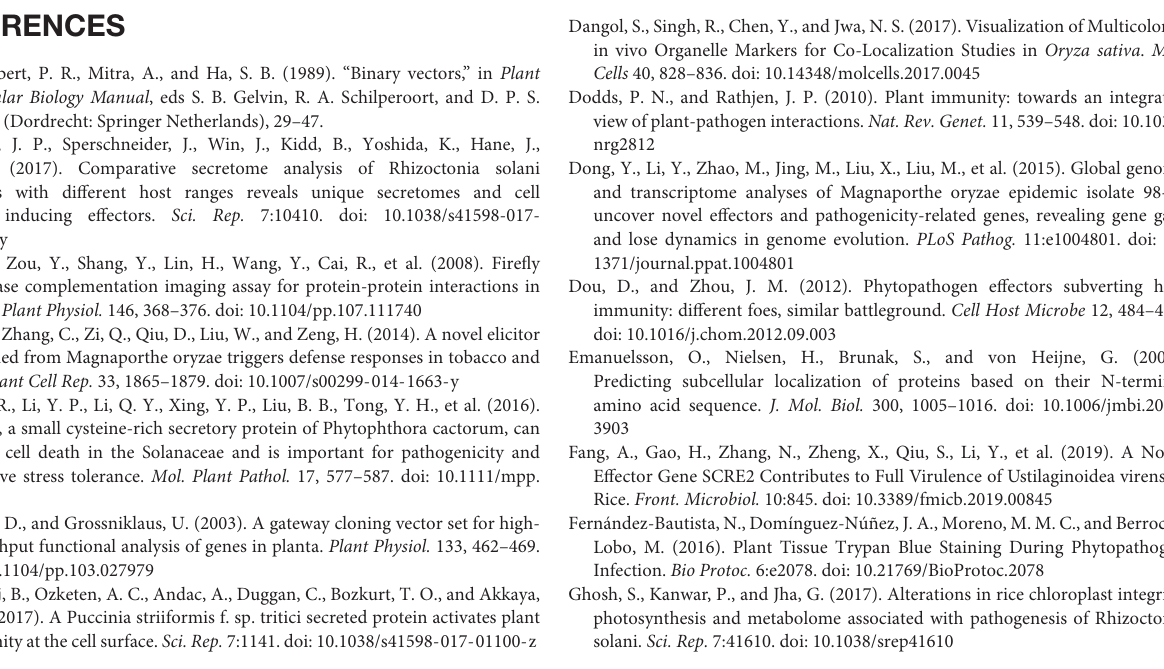
Supplementary Figure 1 | RsSCR10 triggers plant immunity responses in N. benthamiana . (A) Cell death in N. benthamiana leaves indicated by trypan blue staining. GFP and Bax were used as negative and positive controls, respectively. Typical symptoms were photographed at 4 days postinfiltration. (B) Accumulation of ROS and deposition of callose in N. benthamiana . For observation of callose, bars = 100 µ m. Experiments were replicated at least three times. Supplementary Figure 2 | RsSCR10 induced upregulated expression of genes related to H 2 O 2 synthesis in N. benthamiana . Asterisks indicate statistical significance (Student’s t -test) at *5% level and **1% level. Error bars represent standard errors from three biological replicates. Supplementary Figure 3 | Sequence alignment of RsSCR10 in 25 strains of R. solani AG1 IA. Supplementary Figure 4 | RsSCR10 localization analysis in rice protoplasts. (A–D) The fusion protein (RsSCR10-YFP) was coexpressed with the plasma membrane marker (OsPIP2.1-mCherry) (Dangol et al., 2017). (G–J) The fusion protein (RsSCR10-YFP) was coexpressed with the nucleus marker (PR82:2 × RFP-NLSSV40) (Huang et al., 2014). (E,F,K,L) Subcellular localization of the control (GFP) in rice protoplasts. Fluorescence was observed after incubation for 3–16 h. Bars, 50 µ m. All experiments were repeated at least three times. Supplementary Table 1 | Primer sequences used in this